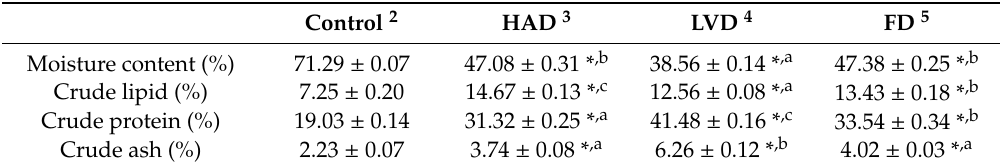
Table 1. Analysis of moisture content, crude lipid, crude protein, and crude ash in the yellow croakers by various drying methods